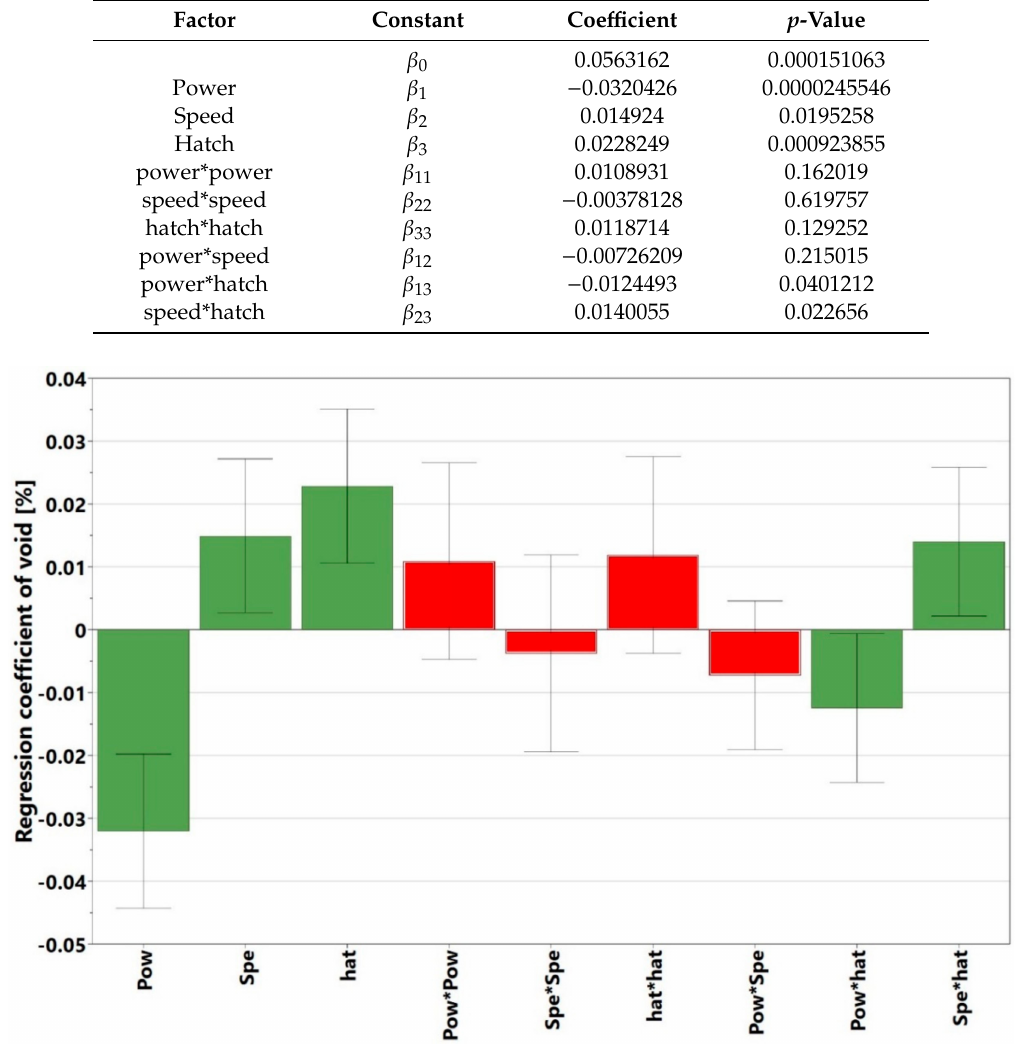
Table 3. Coe ffi cients and p -values of regression constants.